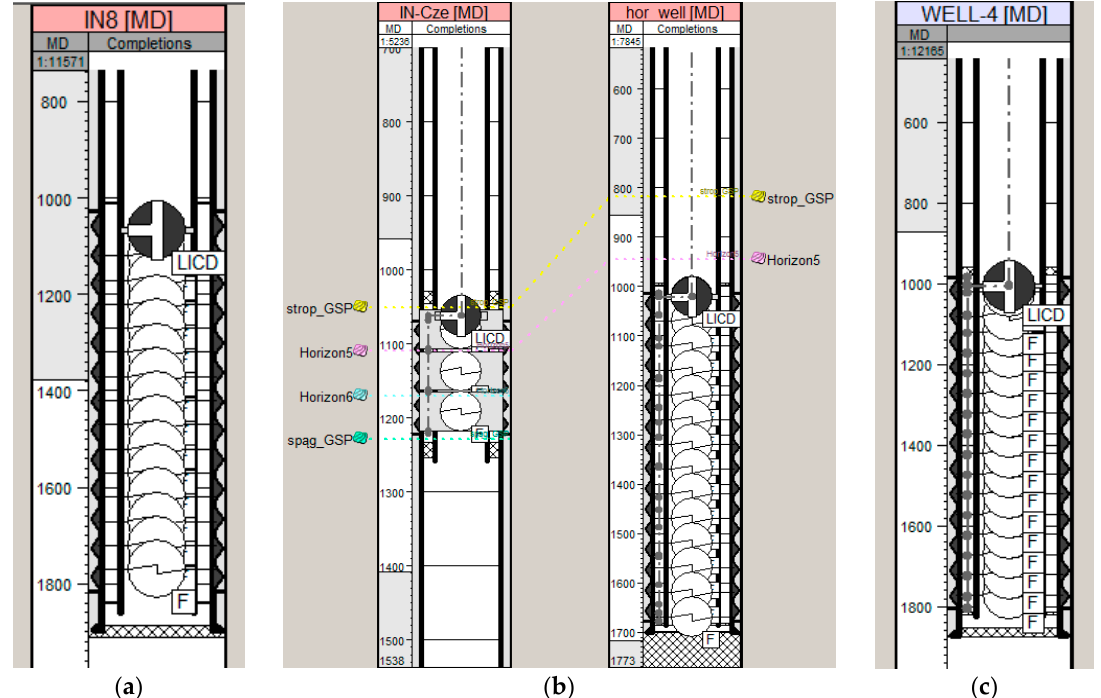
Figure 8. Arrangement of fracturing intervals in injection wells: ( a ) Cracow Sandstone Series, ( b ) Upper Silesian Sandstone Series, ( c ) D ę bowiec formation. Table 5. Characteristics of fractures assumed in the simulation models.